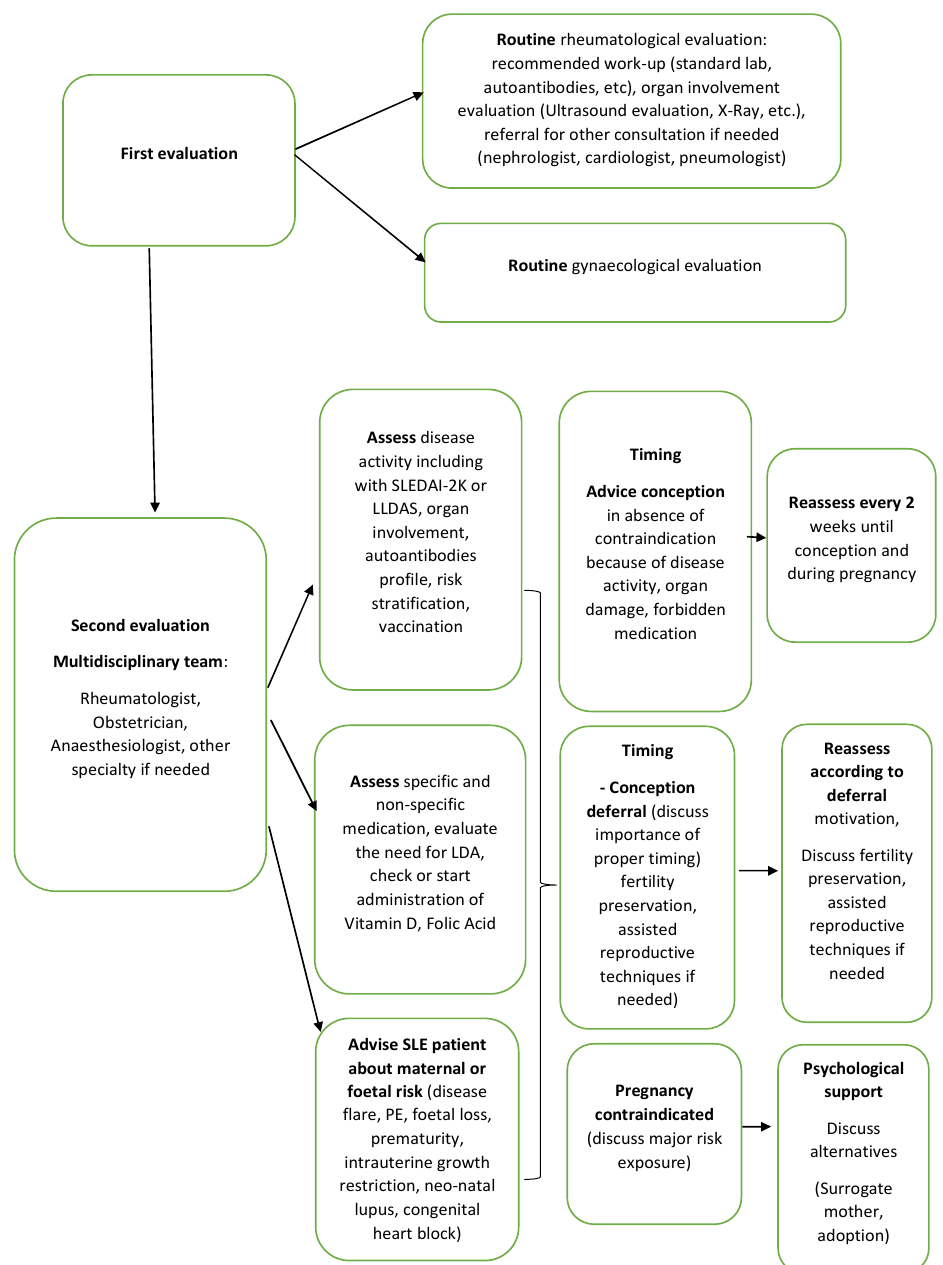
Figure 3. Multidisciplinary team approach for SLE women who desire to conceive. LDA—Low-Dose Aspirin; LLDAS—Lupus Low Disease Activity State; PE—Pre-Eclampsia; SLE—Systemic Lupus Erythematosus; SLEDAI-2K—Systemic Lupus Erythematosus Disease Activity Index